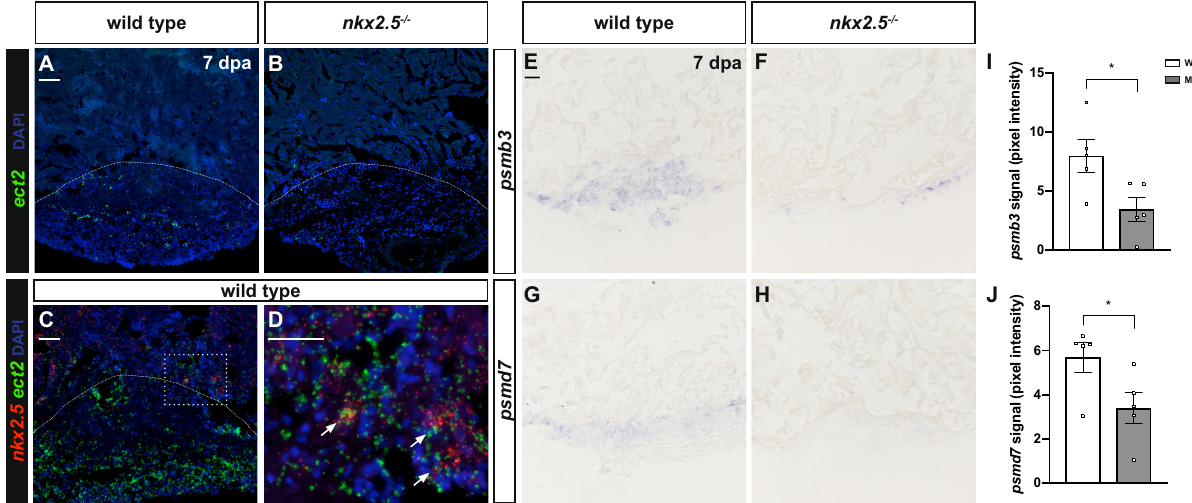
Fig. 7 Nkx2.5 regulates targets, ect2 , psmb3 , and psmd7 , to orchestrate regenerative mechanisms. A , B Representative images of RNAscope analysis on sections of injured hearts at 7 dpa display decreased ect2 expression in the regenerating myocardium of the nkx2.5 − / − ( n = 7) ( B ) compared to the non- transgenic wild-type ( n = 3) ( A ) fi sh. Dashed lines represent amputation planes. Scale bar, 50 μ m. C , D Additional RNAscope analysis employing both nkx2.5 and ect2 probes simultaneously highlight co-localization of transcripts in individual nuclei at the injury border zone in non-transgenic wild-type fi sh ( n = 3) ( C ). Higher magni fi cation panel ( D ) indicates the area outlined in the rectangular box. Scale bar, 50 μ m. E – H In situ hybridization for psmb3 ( E , F ) and psmd7 ( G , H ) in non-transgenic wild-type ( n = 5) ( E , G ) and nkx2.5 − / − ( n = 5) ( F , H ) adult hearts. In nkx2.5 − / − hearts, both psmb3 and psmd7 are downregulated in the injured area. Scale bar, 30 μ m. I , J Quanti fi cation of psmb3 ( I ) and psmd7 ( J ) signal, detected by in situ hybridization, reveals statistically signi fi cant diminution of both genes in the nkx2.5 − / − ( n = 5) compared with the wild-type ( n = 5) injured myocardium. Mean and standard error of each data set are shown. Unpaired, two-tailed t -test illustrate statistically signi fi cant differences in ( I ) ( p = 0.0297) and ( J ) ( p = 0.0468). Source data are provided as a Source Data fi (Fig. 7G) in the regenerate of non-transgenic wild-type hearts. Strikingly, there is diminished expression of these proteasome genes in the wound of nkx2.5 − / − fi sh (Fig. 7F, H). Moreover, pixel intensity quanti fi cation corroborates these histological fi ndings; both psmb3 and psmd7 exhibit a statistically signi fi cant decrease in expression in the wound (Fig. 7I, J). Altogether, we conclude that Nkx2.5 operates via key effectors, ect2 , psmb3 , and